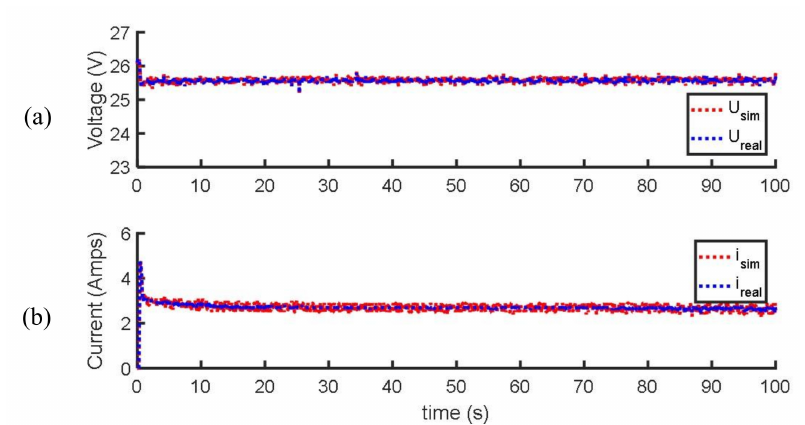
Figure 9. Comparison results between experimental data and simulations: ( a ) Battery voltage, and ( b ) current by traction